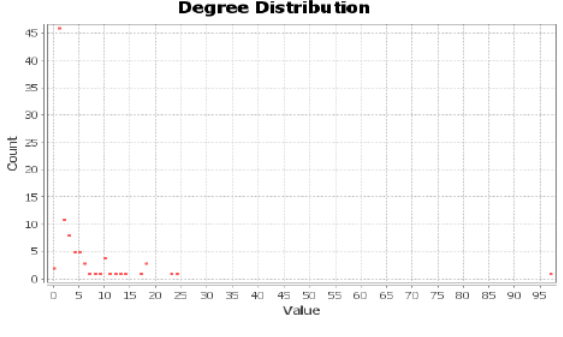
Figure 8: Degree Distribution 2015 Figure 9: Degree Distribution